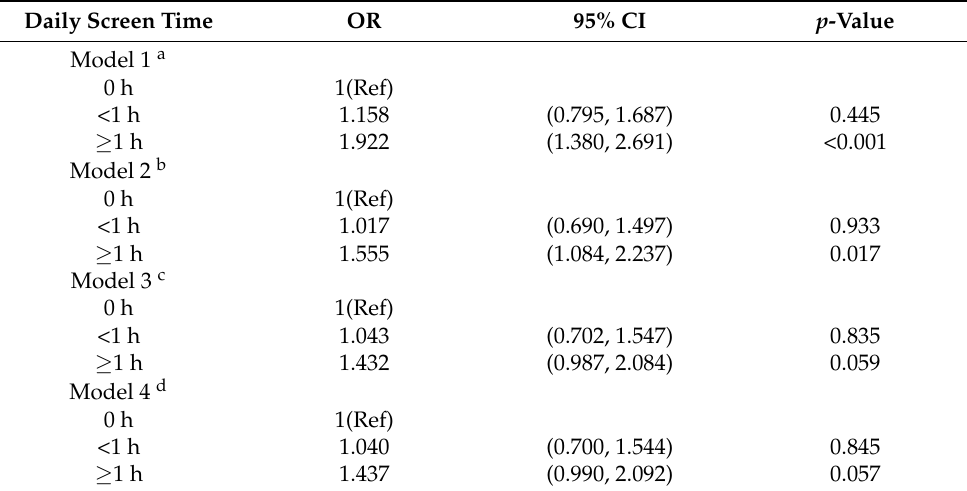
Table 2. Associations between picky eating and daily screen time.